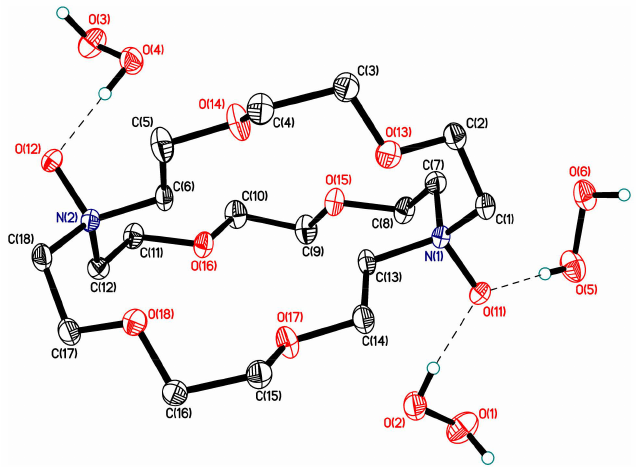
Figure 3. Asymmetric unit of II . Displacement ellipsoids are shown at the 50% probability level. The H-bonds are given by the dashed